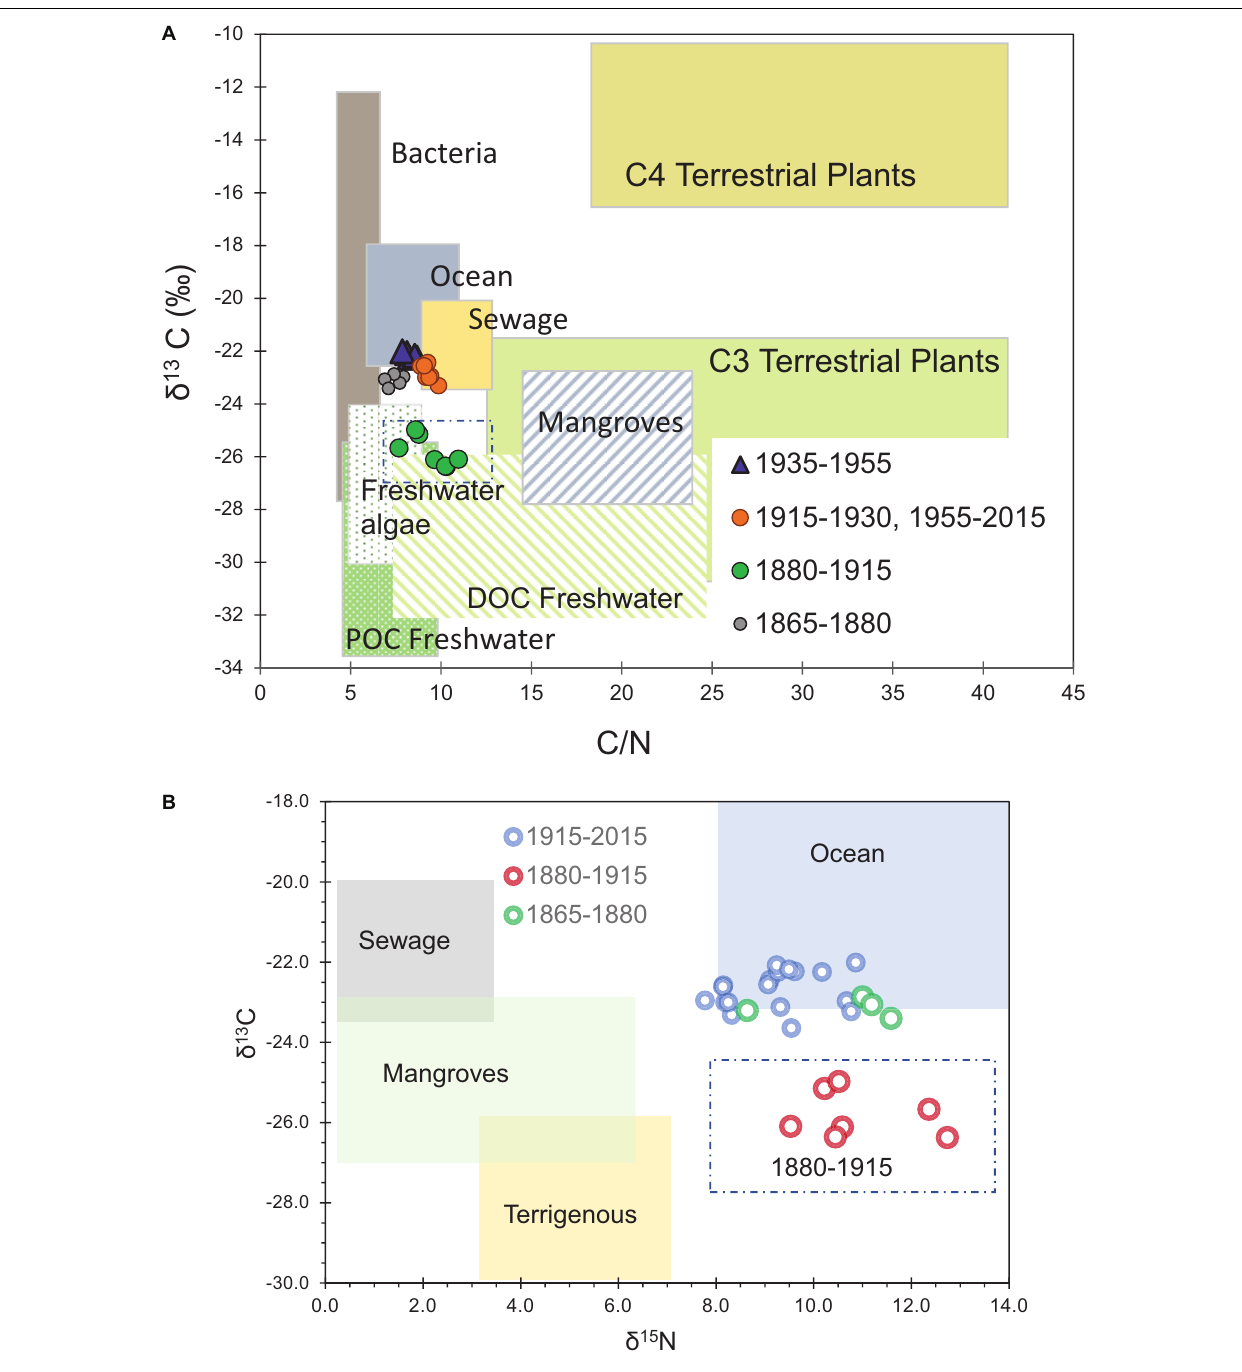
(Liu and Cao, 1984; Wang et al., 2016; Zou et al., 2021) as the following: (1) Rb/K ratio of ≤ 0.004 indicates freshwater conditions; (2) > 0.004 to ≤ 0.006 suggests influence of fresh to brackish water, and; (3) > 0.006 fully marine